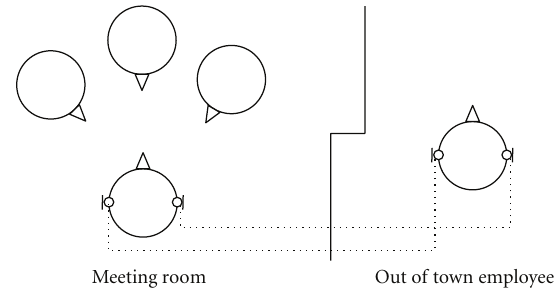
Figure 8: Diagram of audio teleconference where an out-of-town employee is participating the meeting with the help of ARA